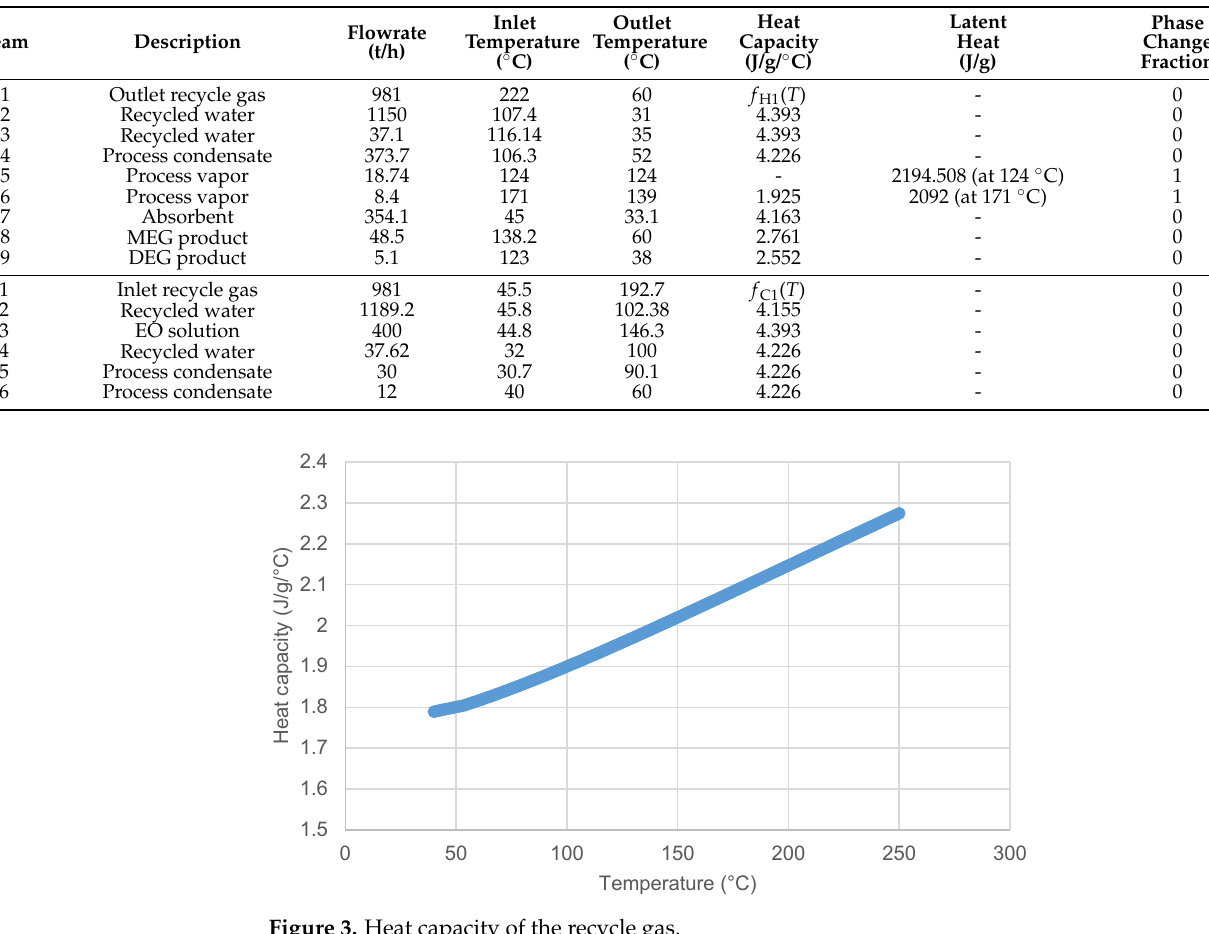
Table 6. Updated process stream data.